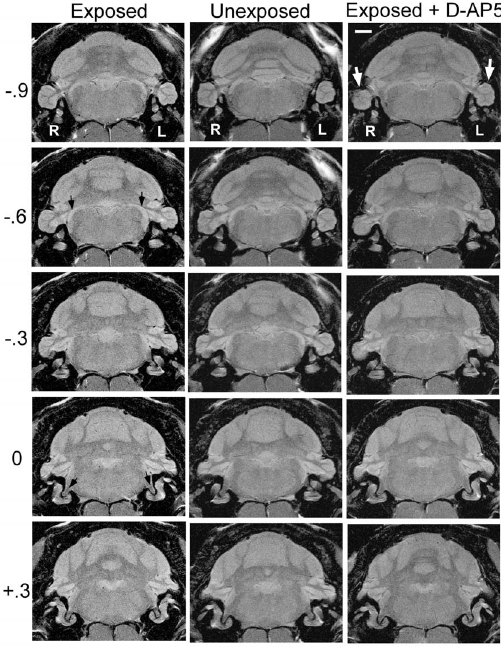
Figure 4. Representative MEMRI scans of an exposed (tinnitus) untreated rat (left column), an unexposed (no-tinnitus) un- treated rat (center column), and an exposed treated rat (right column). Panel rows are indexed with respect to the auditory nerve (dark arrows in row 0). The row labels indicate distance in mm rostral (positive values) or caudal (negative values) to the auditory nerve. The dorsal cochlear nucleus (dark arrows) appears in row 2 0.6 and the paraflocculus (white arrows) in row 2 0.9. The scale bar (top right panel) is 2 mm, R and L indicate the right and left hemispheres, respectively. exposed-D-AP5-treated animal (Fig. 4 right column). The sections, 0.3 mm thick, are indexed with respect to the auditory nerve (Fig 4., dark arrows, row 0, left column), and extend from the cochlear nucleus (Fig. 4, dark arrows, row -.6, left column) through the PFL (Fig. 4, light arrows, row -.9, right column). Average group results are summarized in Fig. 5 (top panel) for the ipsilateral pathway, and in Fig. 5 (bottom panel) for the contralateral pathway. Three significant effects were obtained (statistics summarized in Table 2): (a) Neural activity was elevated in the exposed untreated DCN and exposed untreated PFL, in